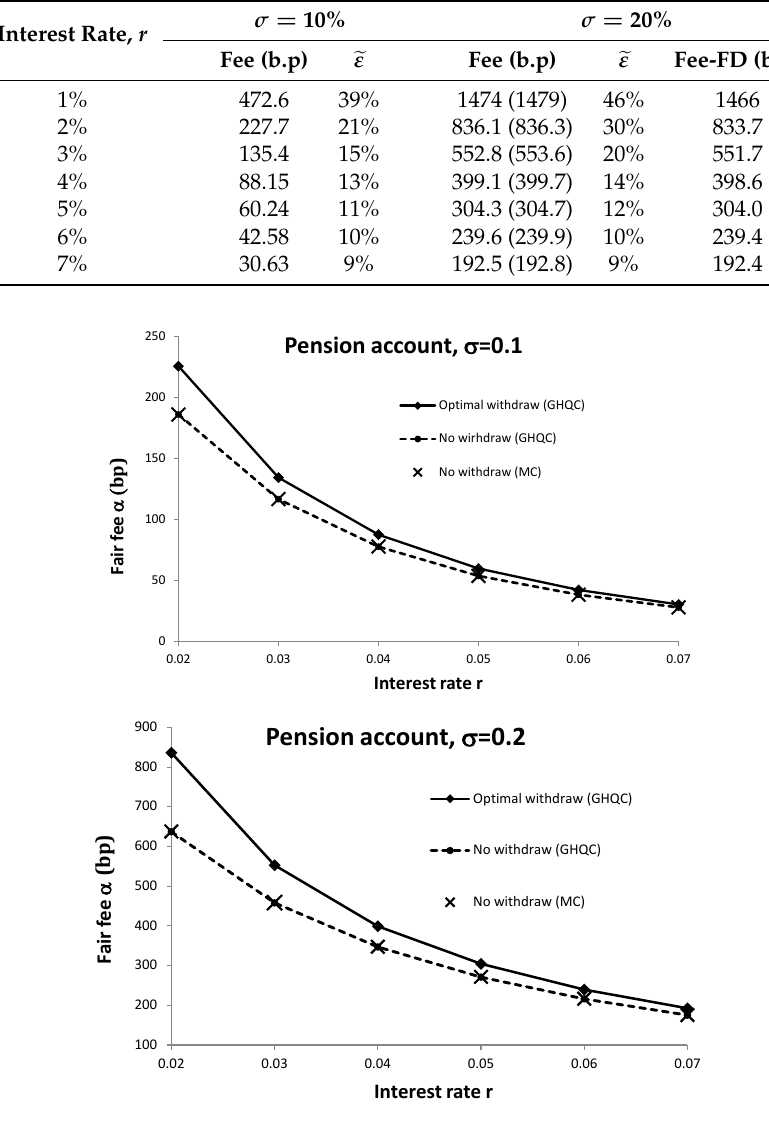
Figure 2. Fair fee α in bp as a function of the interest rate r at σ = 10% and σ = 20% for the GMAB on a pension account when withdrawals are optimal, in comparison with the static case where no withdrawal is allowed. Values are taken from Tables 1 and 4,